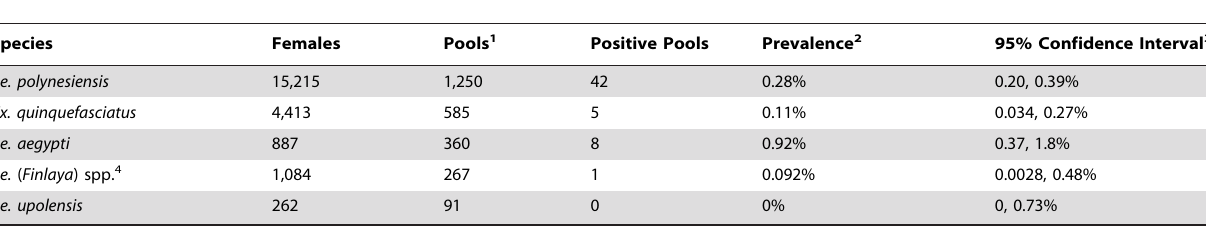
Table 1. Detection of W. bancrofti DNA in American Samoa mosquitoes by PCR.